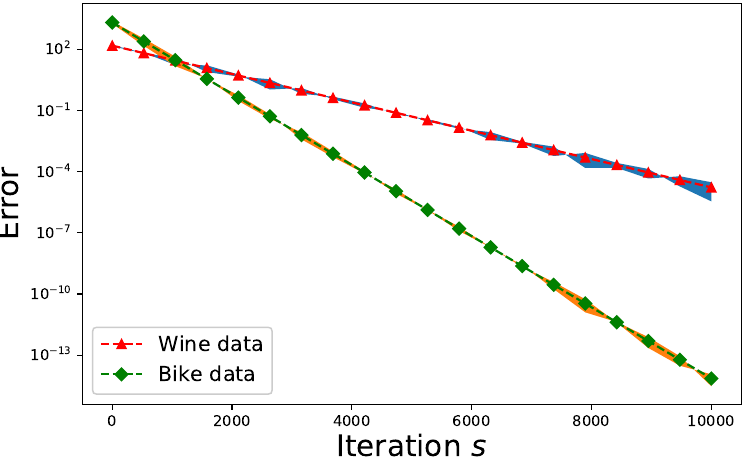
Figure 6. Error-convergence comparison for the wine data and the bike-rental